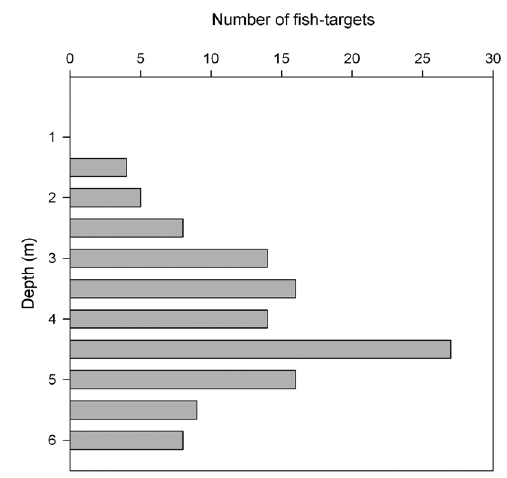
Figure 4. Vertical distribution of all insonified targets through echo-counting technique, by depth strata, in Lagoa Santa, April 28, 2008.